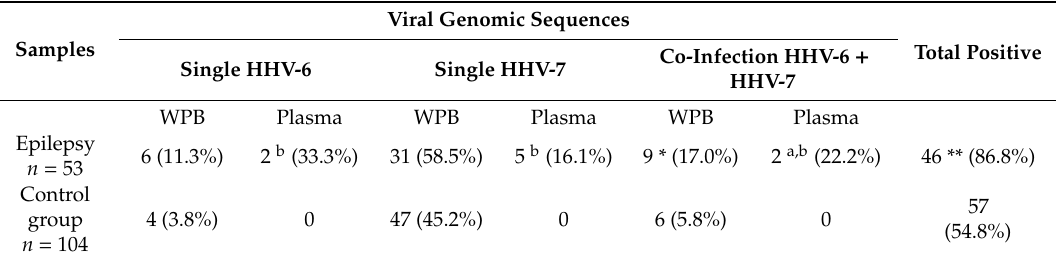
Table 1. Presence of HHV-6 and / or HHV-7 genomic sequences in whole peripheral blood and cell-free plasma DNA samples of the patients with epilepsy and control group